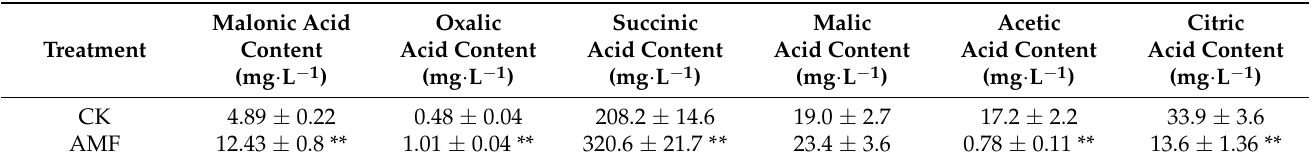
Table 2. Effects of AMF on the secretion of low-molecular-weight organic acids in maize